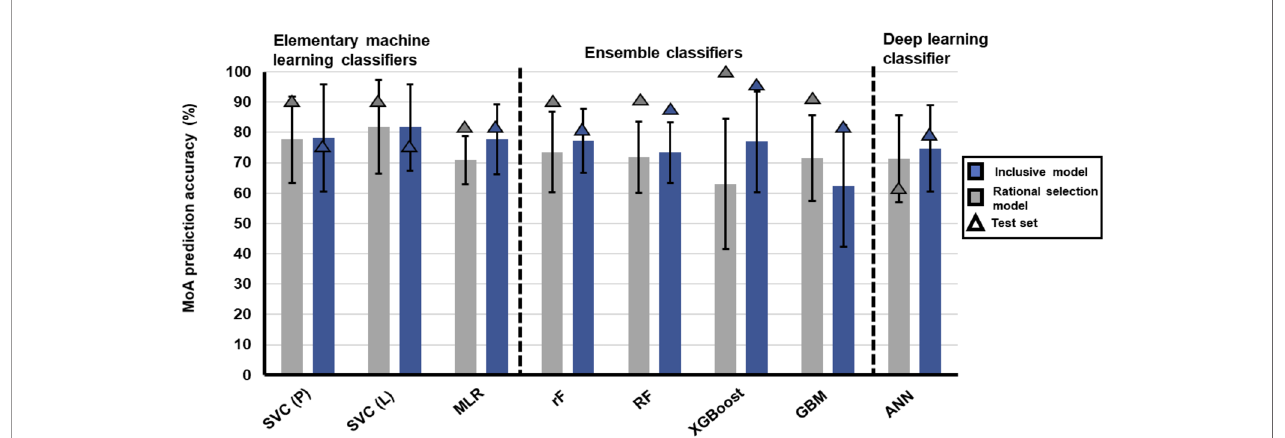
FIGURE 2 | Robustness and accuracy of different ML algorithm ’ s ability to stratify treatments with similar MoA using either the 2463-transcript inclusive database or 174-transcript rational selection database. Different ML algorithms are grouped according to statistics-driven elementary ML, ensemble or deep learning classi fi ers. Algorithm classi fi ers were either trained on the 2463-transcript inclusive database (blue) or 174-transcript rational selected database (gray). Classi fi ers were hyperparameter tuned before undergoing 10-fold cross-validation. Bars indicate the average accuracy of the classi fi er obtained from 10-fold cross-validation on the training data and the error bars are the standard deviation of performance measures. Triangles indicate the accuracy of the classi fi er in stratifying the MoA of test data. Some ML algorithms had variations in R packages that could be used for model building, which were also interrogated. SVC, support vector classi fi cation with the1071 R package; P, polynomial; L, linear; MLR, multinomial logistic regression; rF, random forest with randomForest R package; RF, random forest with h2o R package; XGBoost, built with xgboost R package, GBM, gradient boosting machine; ANN, arti fi cial neural network. MLR. RF GBM and ANN was built using h2o R